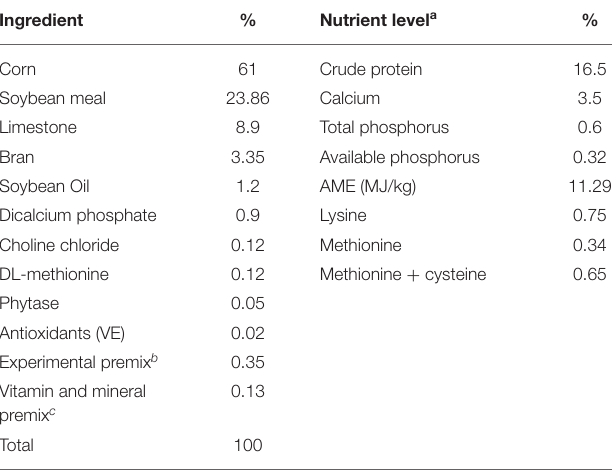
TABLE 1 | Dietary composition and nutrient levels of the basal